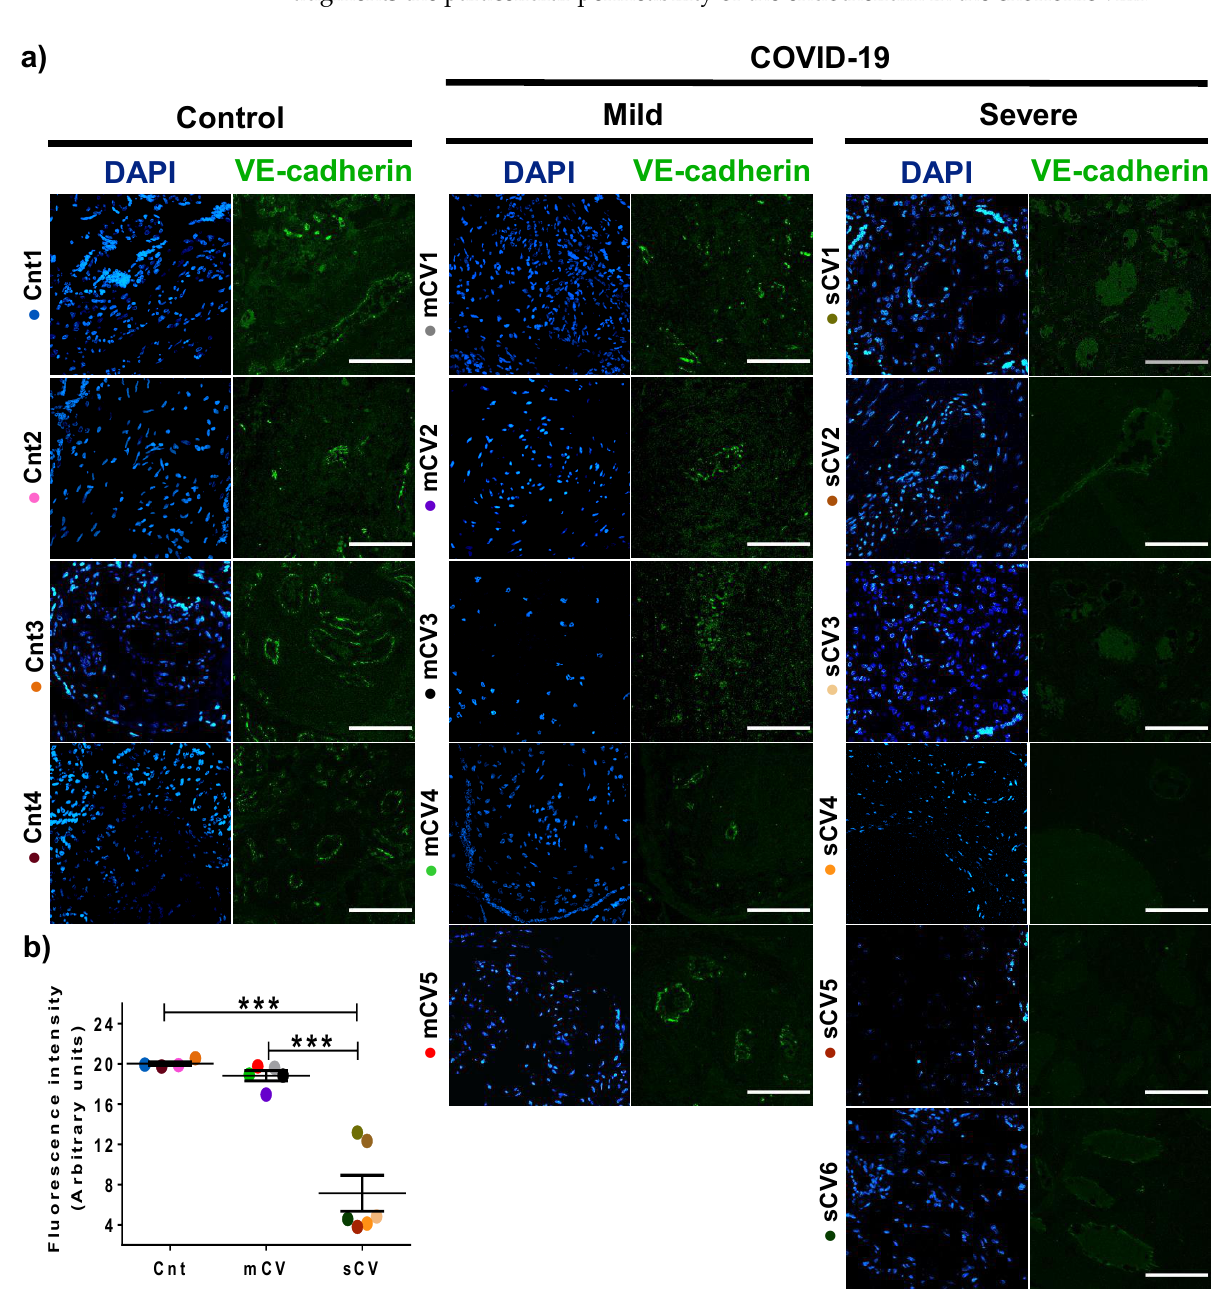
Figure 5. VE-cadherin expression in decidual endothelium decreases in placentas from women with severe COVID-19 but no in those with mild disease. Paraffin blocks of placental tissue derived from women with COVID-19 and controls were cut in 1 µm slices, deparaffinized, and processed for immunofluorescence with antibodies against VE-cadherin. ( a ) Representative images of VE-cadherin in decidua. DNA of nuclei was stained with DAPI. Bar, 100 µ m. ( b ) Quantification of mean fluorescent intensity done on three independent images from each condition. Data are expressed as mean ± SD; F test with Welch correction followed by the multiple comparison tests of Bonferroni and Dunnett, *** p < 0.001. Cnt, control; mCV, mild COVID-19; sCV, severe COVID-19.